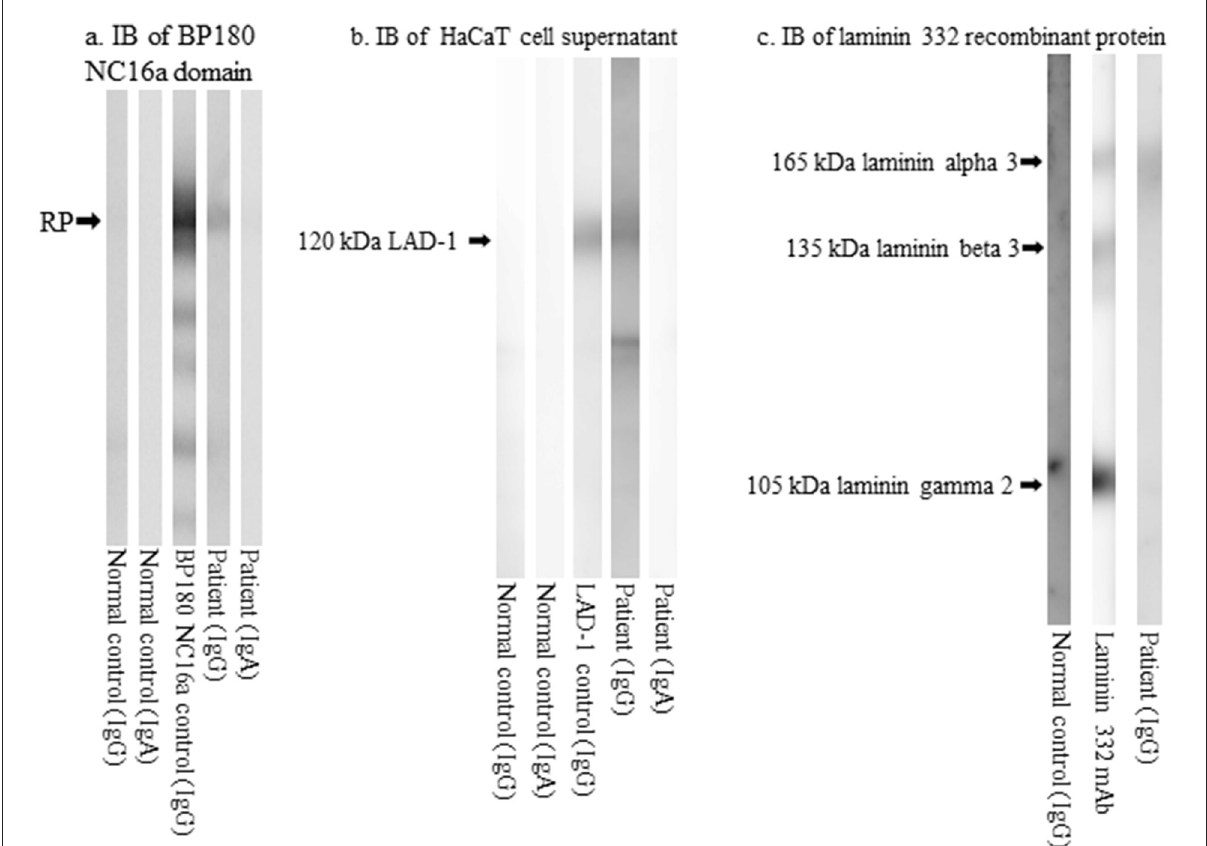
FIGURE3 The results of immunoblotting analyses. (a) Immunoblotting of the RPs of BP180 NC16a domain showing IgG reactivity with the RPs. (b) Immunoblotting of concentrated culture supernatant of HaCaT cells showing IgG reactivity with the 120 kDa LAD-1. (c) Immunoblotting of RPs of laminin 332 showing IgG reactivity with the 165 kDa laminin α 3. RP, recombinant protein; BP, bullous pemphigoid; LAD-1, linear IgA disease antigen 1; Ig, immunoglobulin.